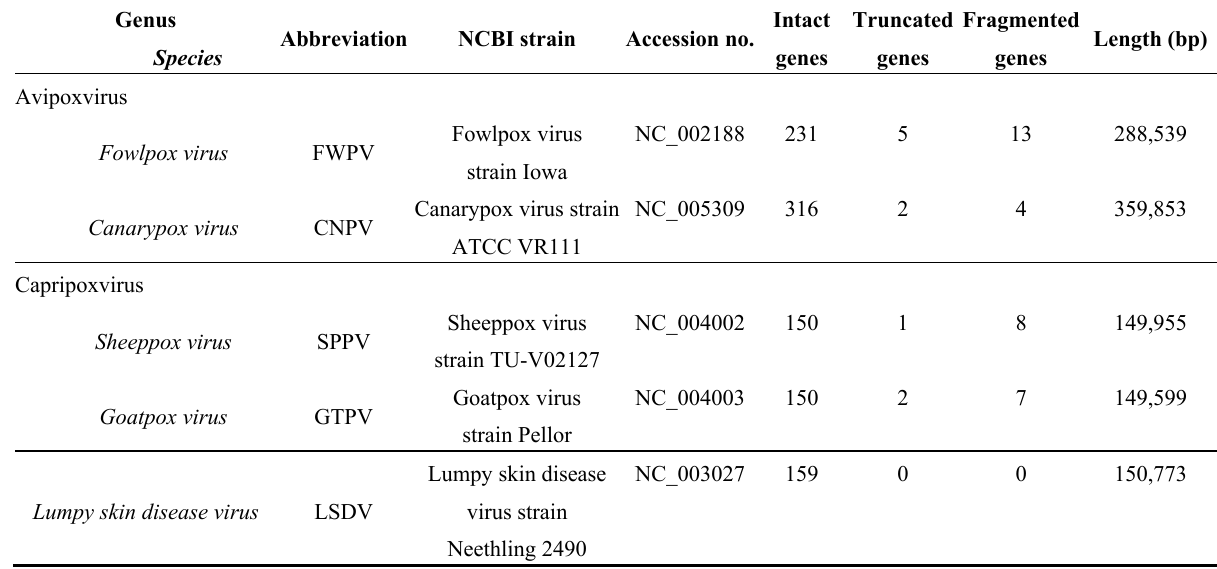
Table 1. Selected chordopoxvirus genomes used in these